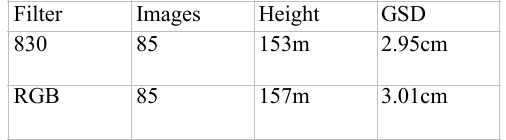
Table 2. ADS sensor evolution